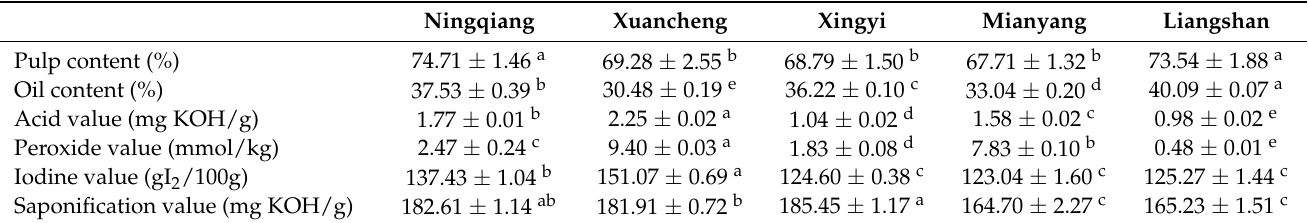
Table 1. Pulp content of I. polycarpa , oil content of I. polycarpa pulp, and chemical properties of IPPO from five